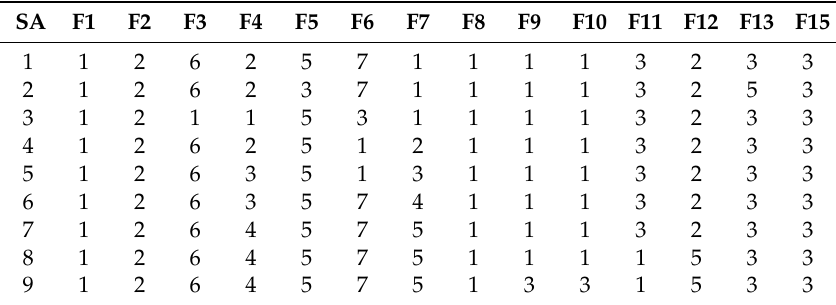
Table 6. For best combo of each SA: F methods